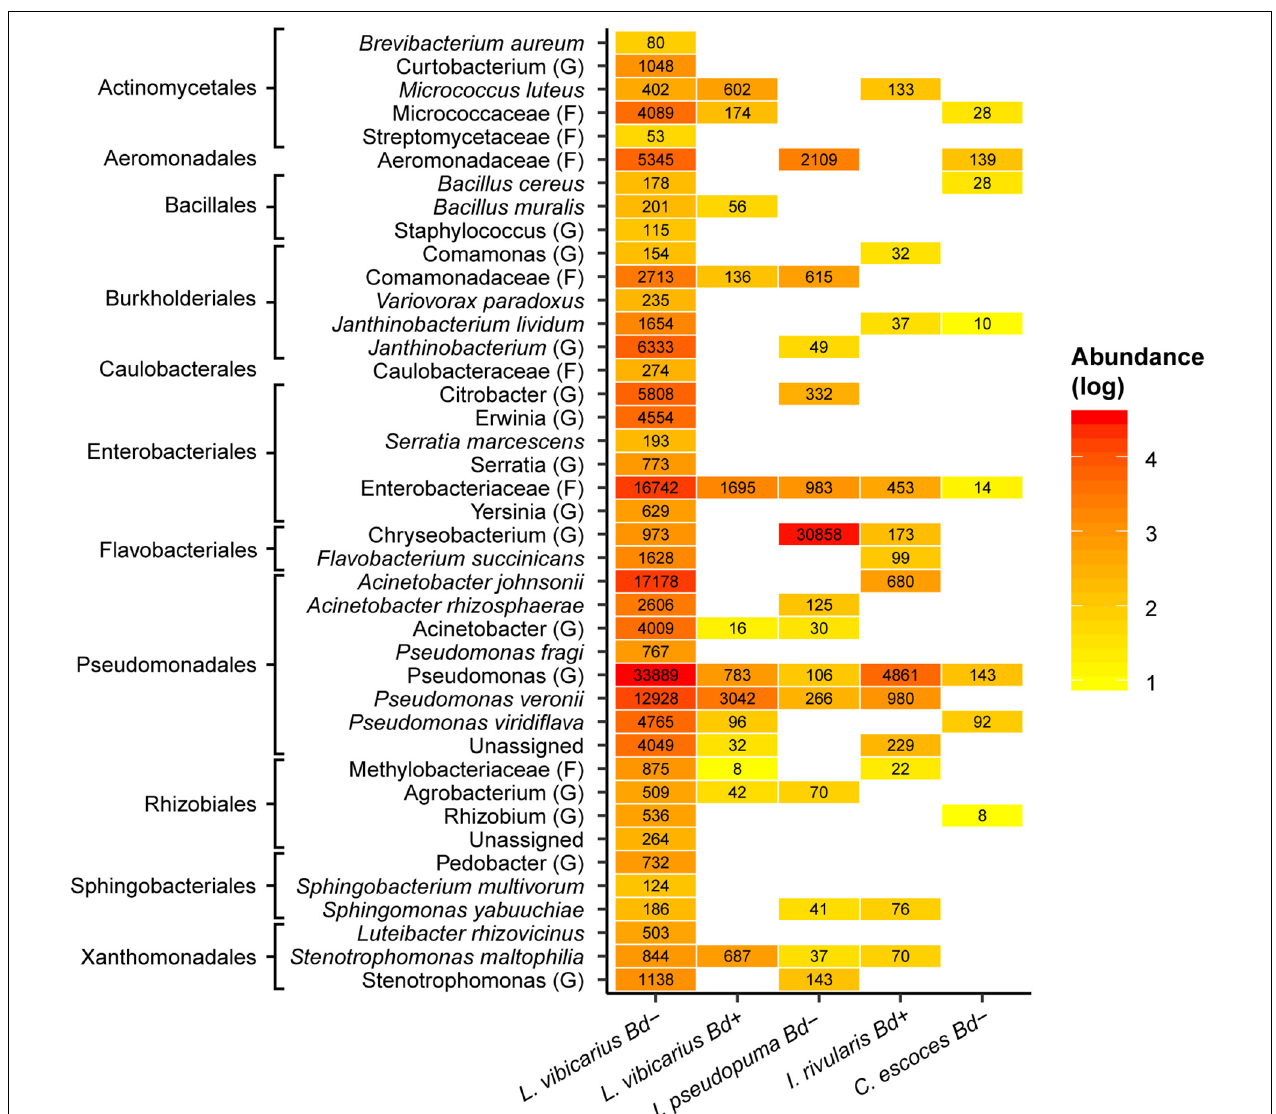
FIGURE 2 | Heatmap of putatively anti- Bd ASVs across adults of four sympatric species grouped by Bd infection status. Reddish colors indicate increasing abundance, yellowish colors indicate lower abundance, whereas white indicates absence of ASVs. The highest possible taxonomic assignment (maximal at the species level) is shown for these ASVs. The numbers indicate the total number of reads of ASVs assigned to specific taxa. G, genus; F,